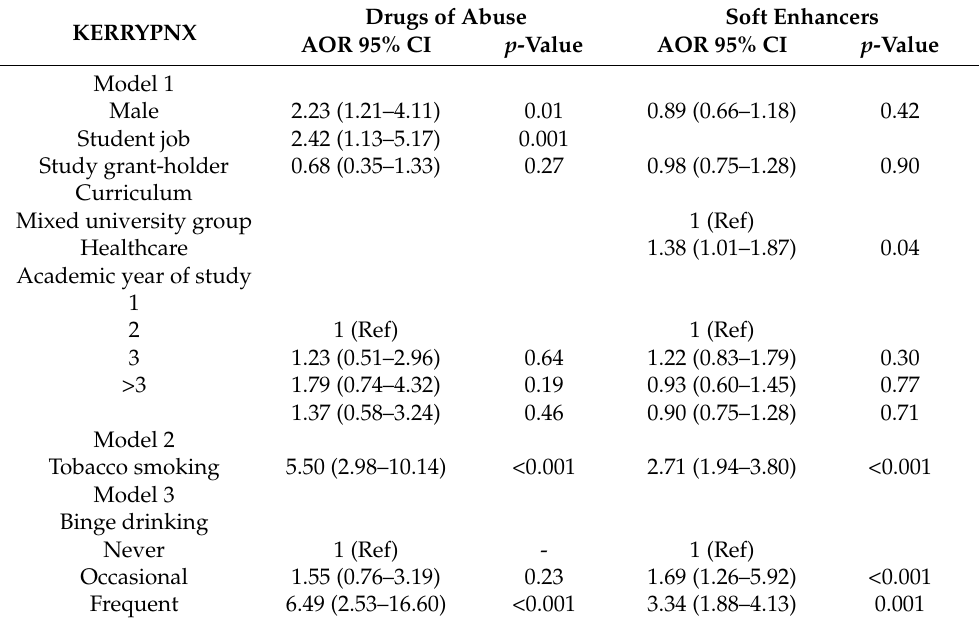
Table 4. Logistic regression analysis of the factors associated with neuroenhancement among univer-